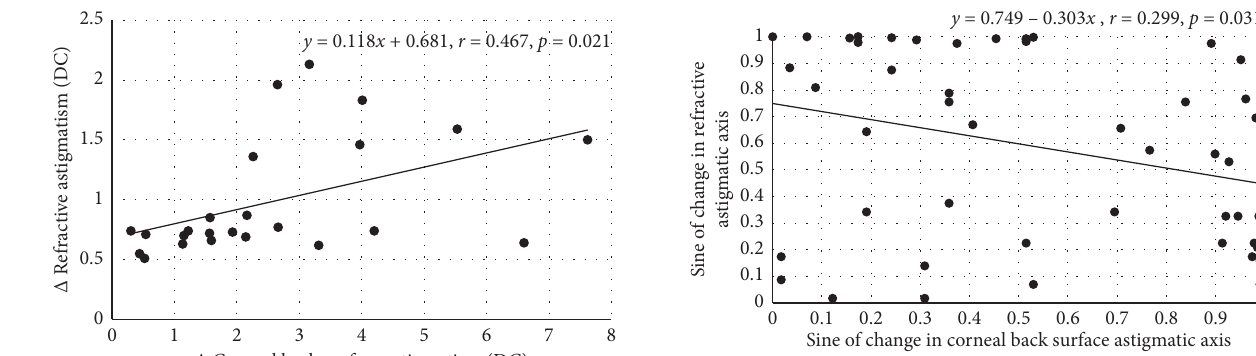
Figure 3: Change in the sine of the axis of astigmatism at the corneal back surface over the central 3mm zone ( x axis) and the corresponding change in the sine of the axis of residual refractive astigmatic error determined by autorefractometry ( y axis) between 1 and 2 months postoperatively. All units are sine of axis in degrees ( °